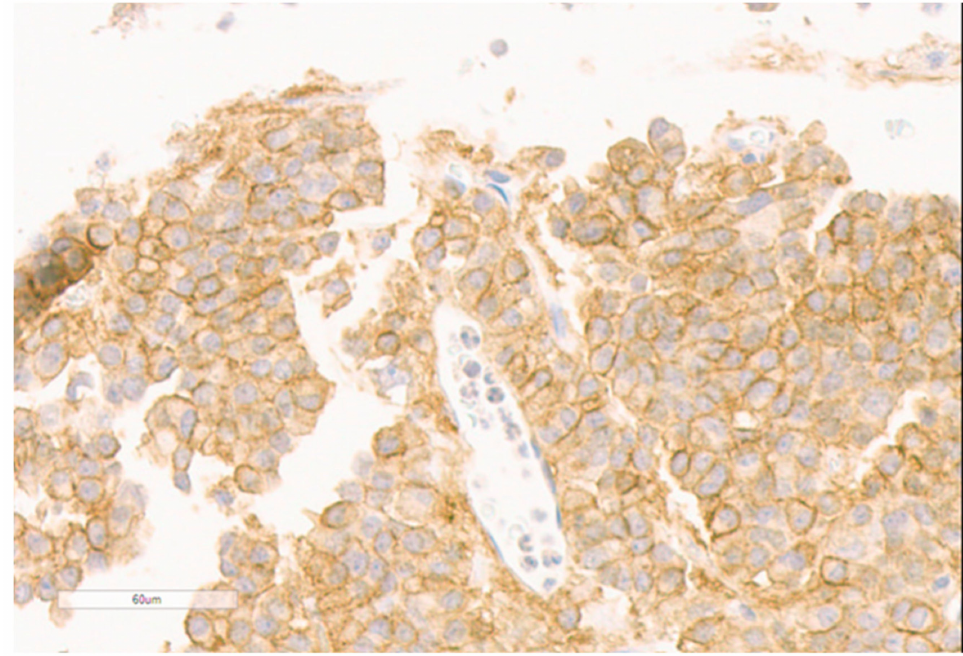
Figure 3. SSTR subtype 5 can be observed in about 70% of the cells at an intensity of level 2; IRS is therefore 6 (patient